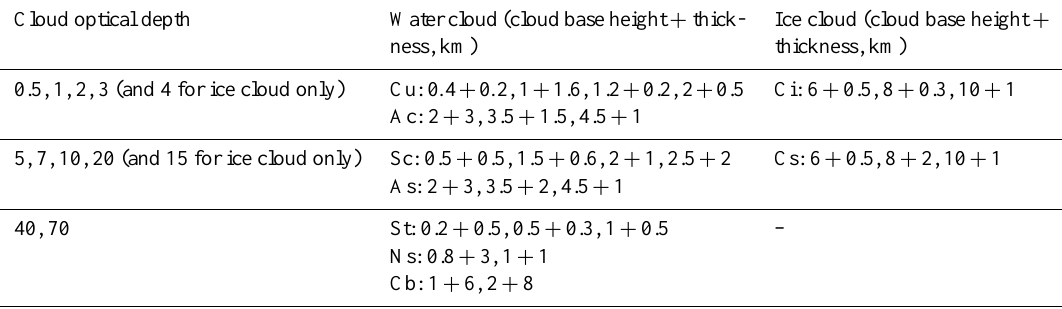
Table 3. Selected cloud properties